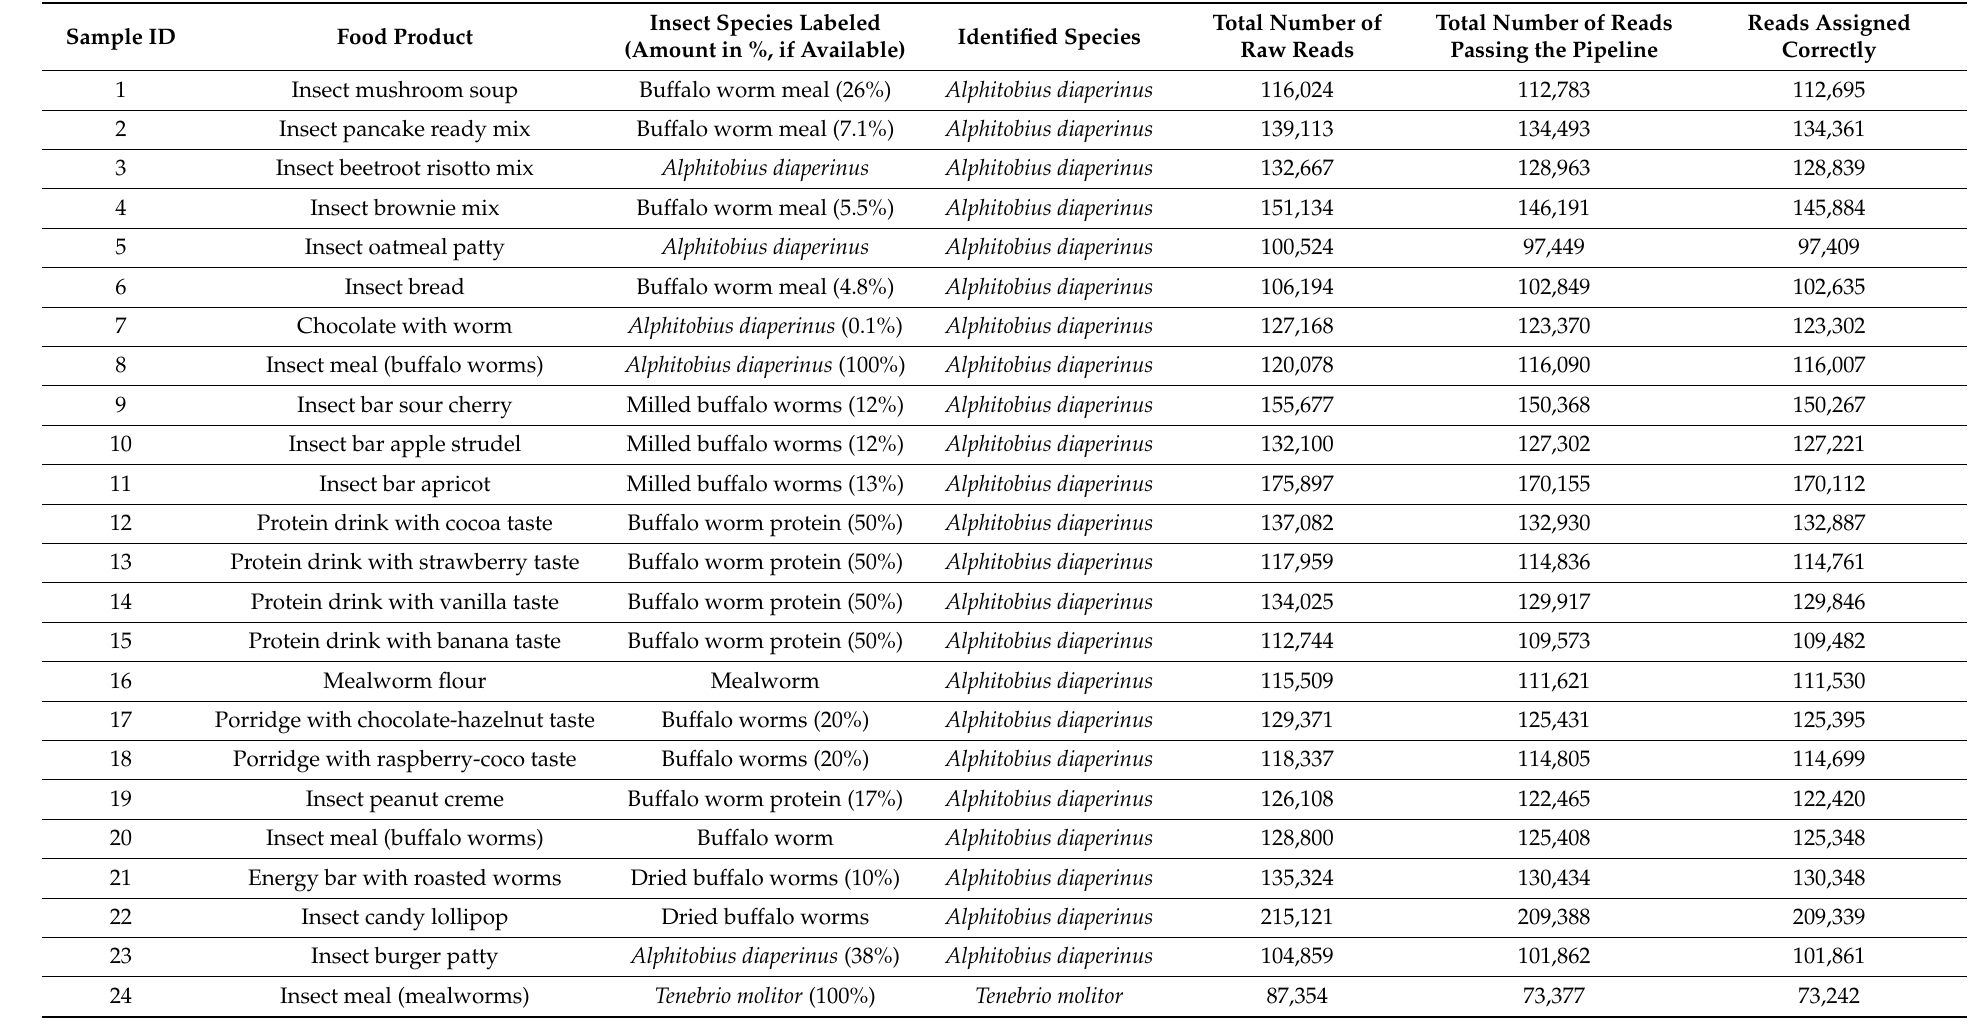
Table 5. Results obtained from commercial insect samples. Samples were sequenced either with the MiSeq ® or the iSeq ®